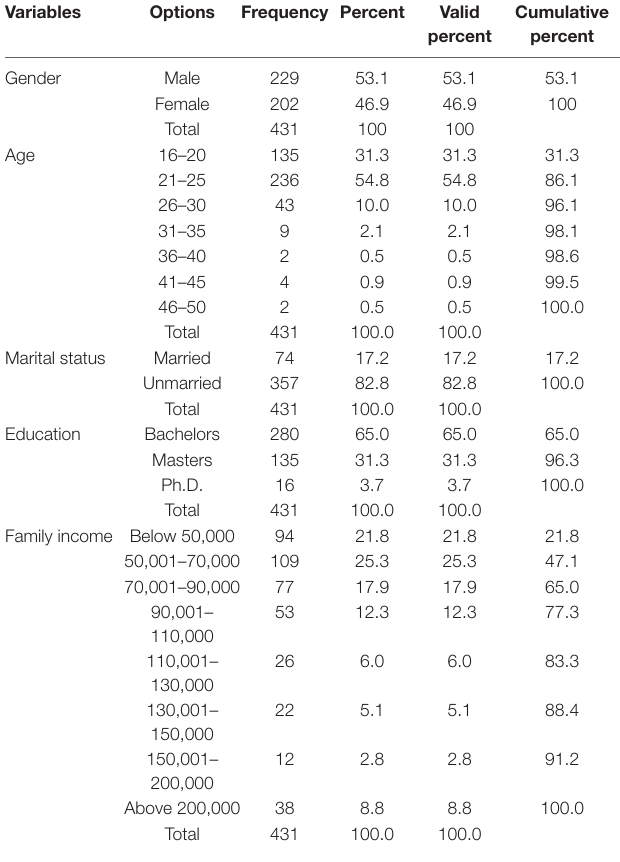
TABLE 1 | Profile of respondents from